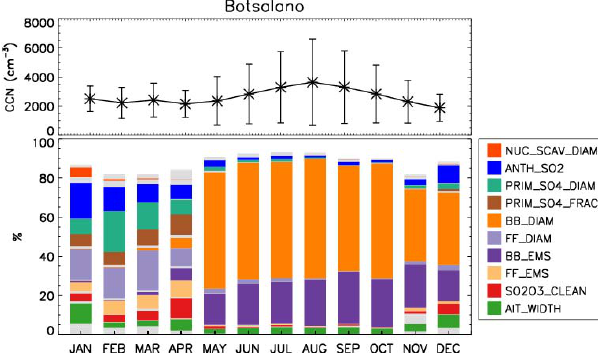
Fig. A1. Upper panel: the seasonal cycle of CCN concentrations at the surface at the Botsalano site together with the 2-sigma un- certainty range due to uncertainty in 28 model parameters. Lower panel: the fraction of variance in CCN attributable to various emis- sions and processes, indicated by the colour